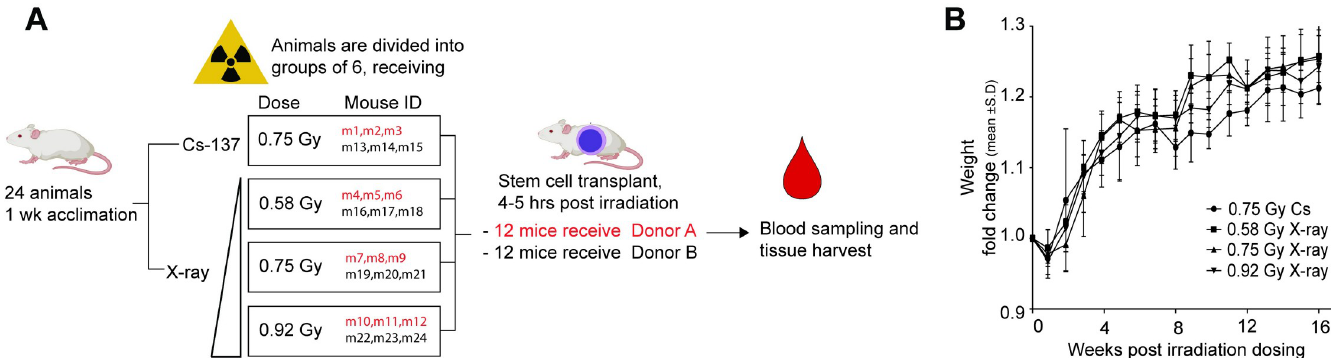
Fig 1. Experimental layout and mouse weight development. (A) Overview of the experimental plan, 24 animals were randomized into 4 irradiation groups. One group received the standard dose in our lab for Cesium-based preconditioning (0.75 Gy of Cs-137 radiation). The remaining mice were divided into three groups that receive either 0.58 Gy, 0.75 Gy or 0.92 Gy of X-ray-derived radiation. The vertical triangle ( ◿ ) illustrates increasing doses of X-ray-derived radiation. In each group 3 of the 6 mice received stem cells from donor A, the remaining 3 from donor B. (B) For each group, the starting weight of the individual mice (the same week, pre-engraftment to irradiation (p.e.) were set to the value 1). The recorded weight for the following week is presented as the fold-change from this starting weigh for each specific mouse. Each group is the fold changes for all the mice in each group, presented as mean ± S.D. Weight is an overall estimate of health status of the mice. The mice were exposed 1 or 2 days after p.e. (week 0) weight data were